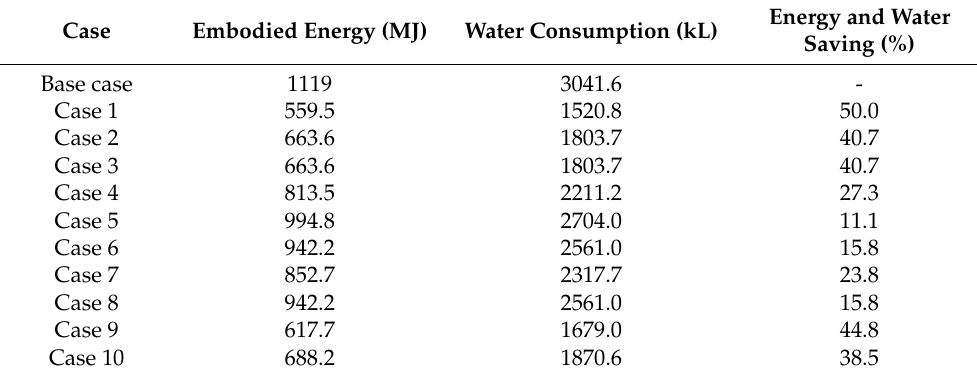
Table 5. Embodied energy, water usage, and corresponding saving for different metal foam configu- rations at the flow rate of 120 L/h.